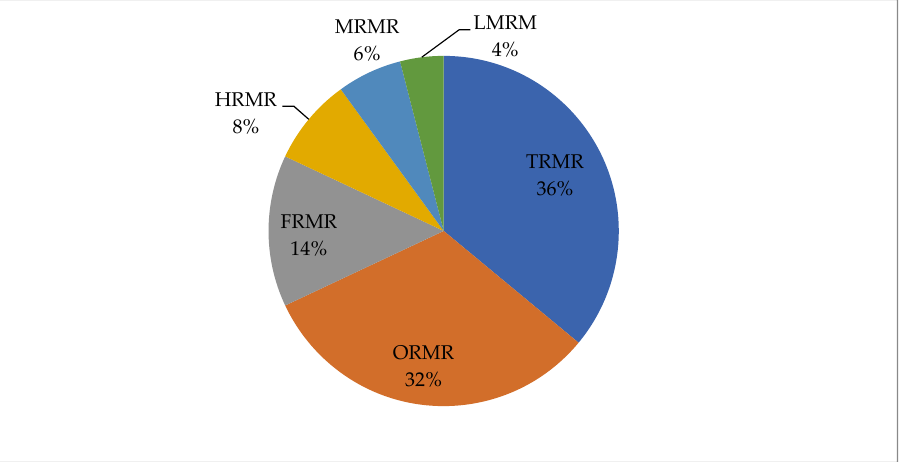
Figure 1. Risk competencies of enterprise resource management. Abbreviations are as defined in Table 1.